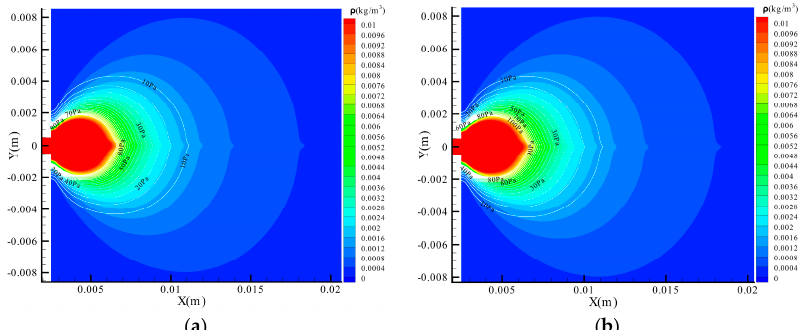
Figure 12. Velocity contour of different external temperature. ( a ) 393 K; ( b ) 173 K.